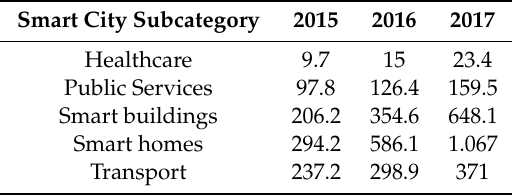
Table 2. Connected devices in the smart city subcategory (in millions).